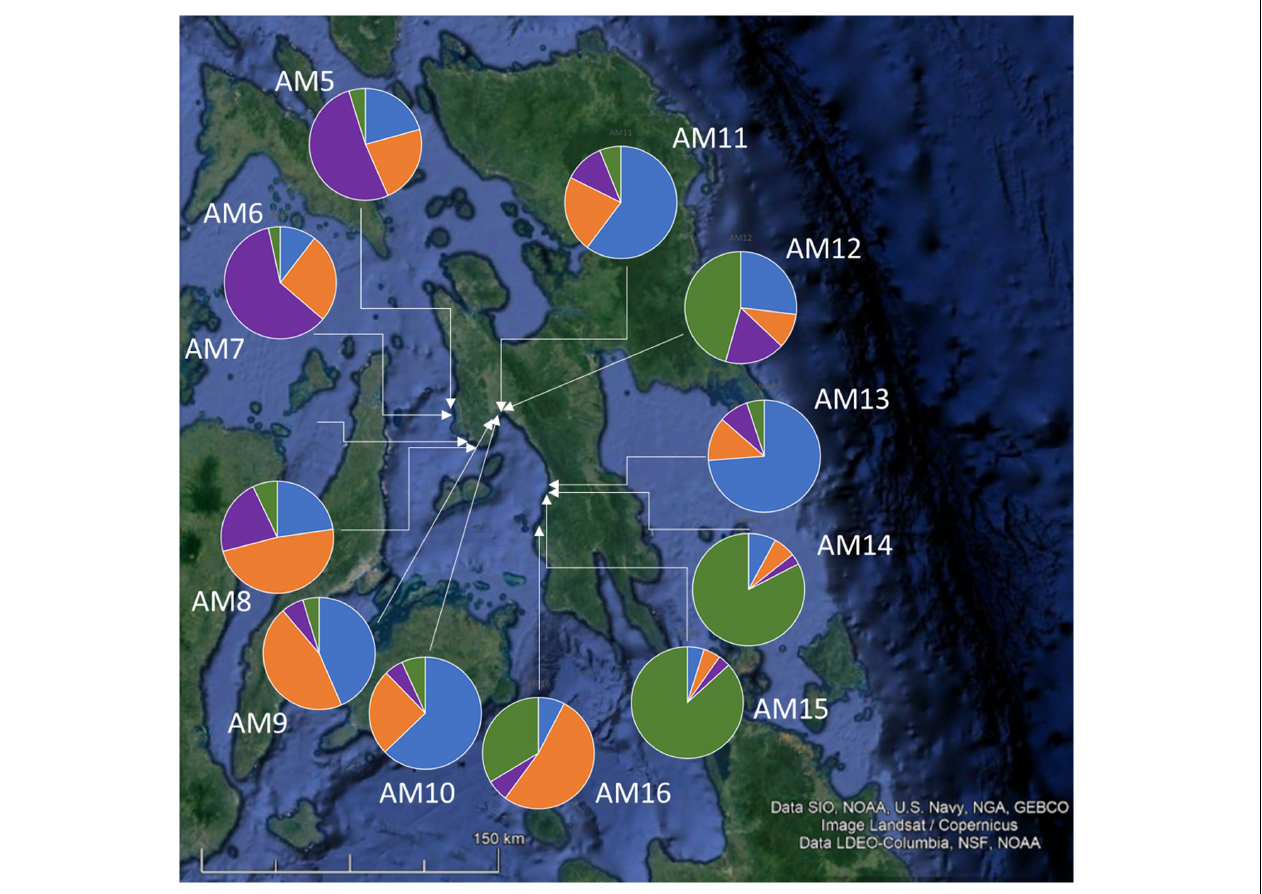
FIGURE 2 | STRUCTURE results for K = 4 with pie charts for Avicennia marina populations AM5 to AM16 of Western Leyte showing a South-North